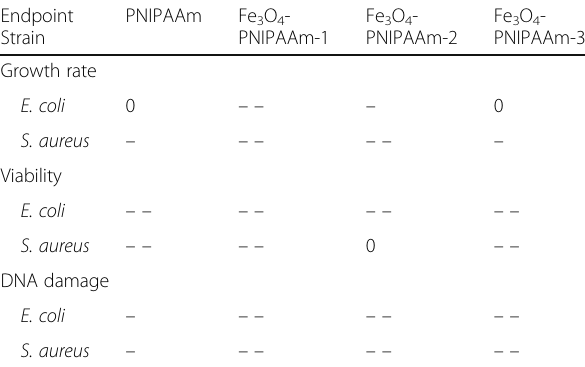
Table 2 Summary of the antimicrobial effect of PNIPAAm and three nanocomposites on Escherichia coli and Staphylococcus aureus Endpoint Strain